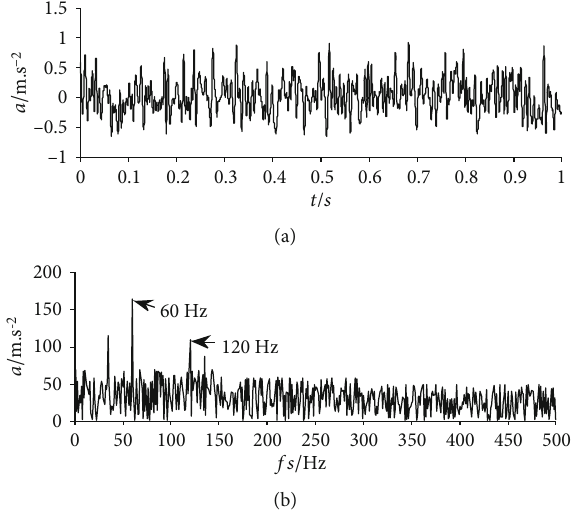
Figure 2: Waveform and frequency spectrum of the simulated signal denoised by the dual-tree complex wavelet. (a) Waveform. (b) Frequency spectrum.